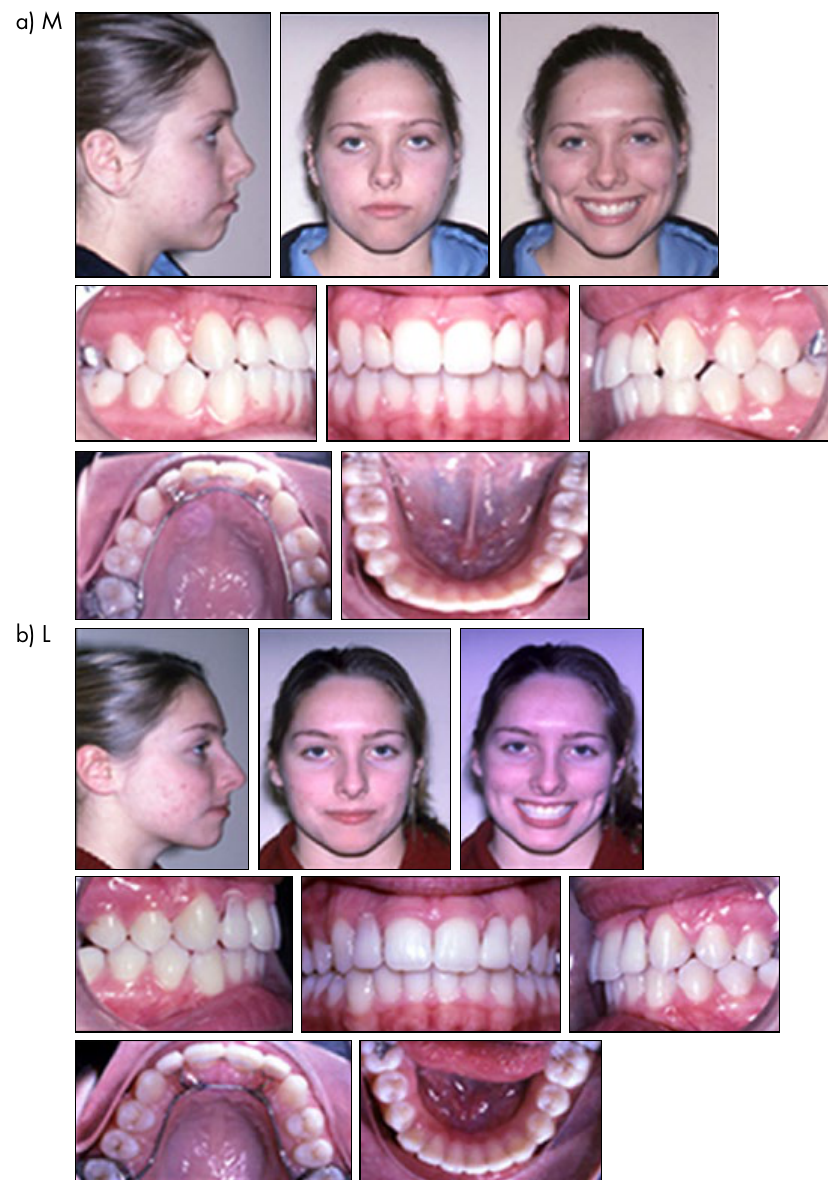
Figure 10. Facial and intraoral photographs with prosthetic replacement of the maxillary lateral incisors on a lingual arch at age